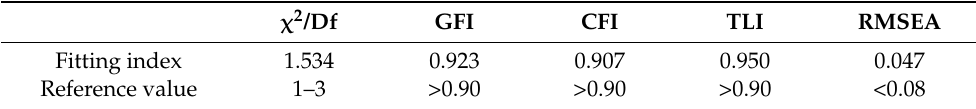
Table 3. Fitting indexes of six-factor integration